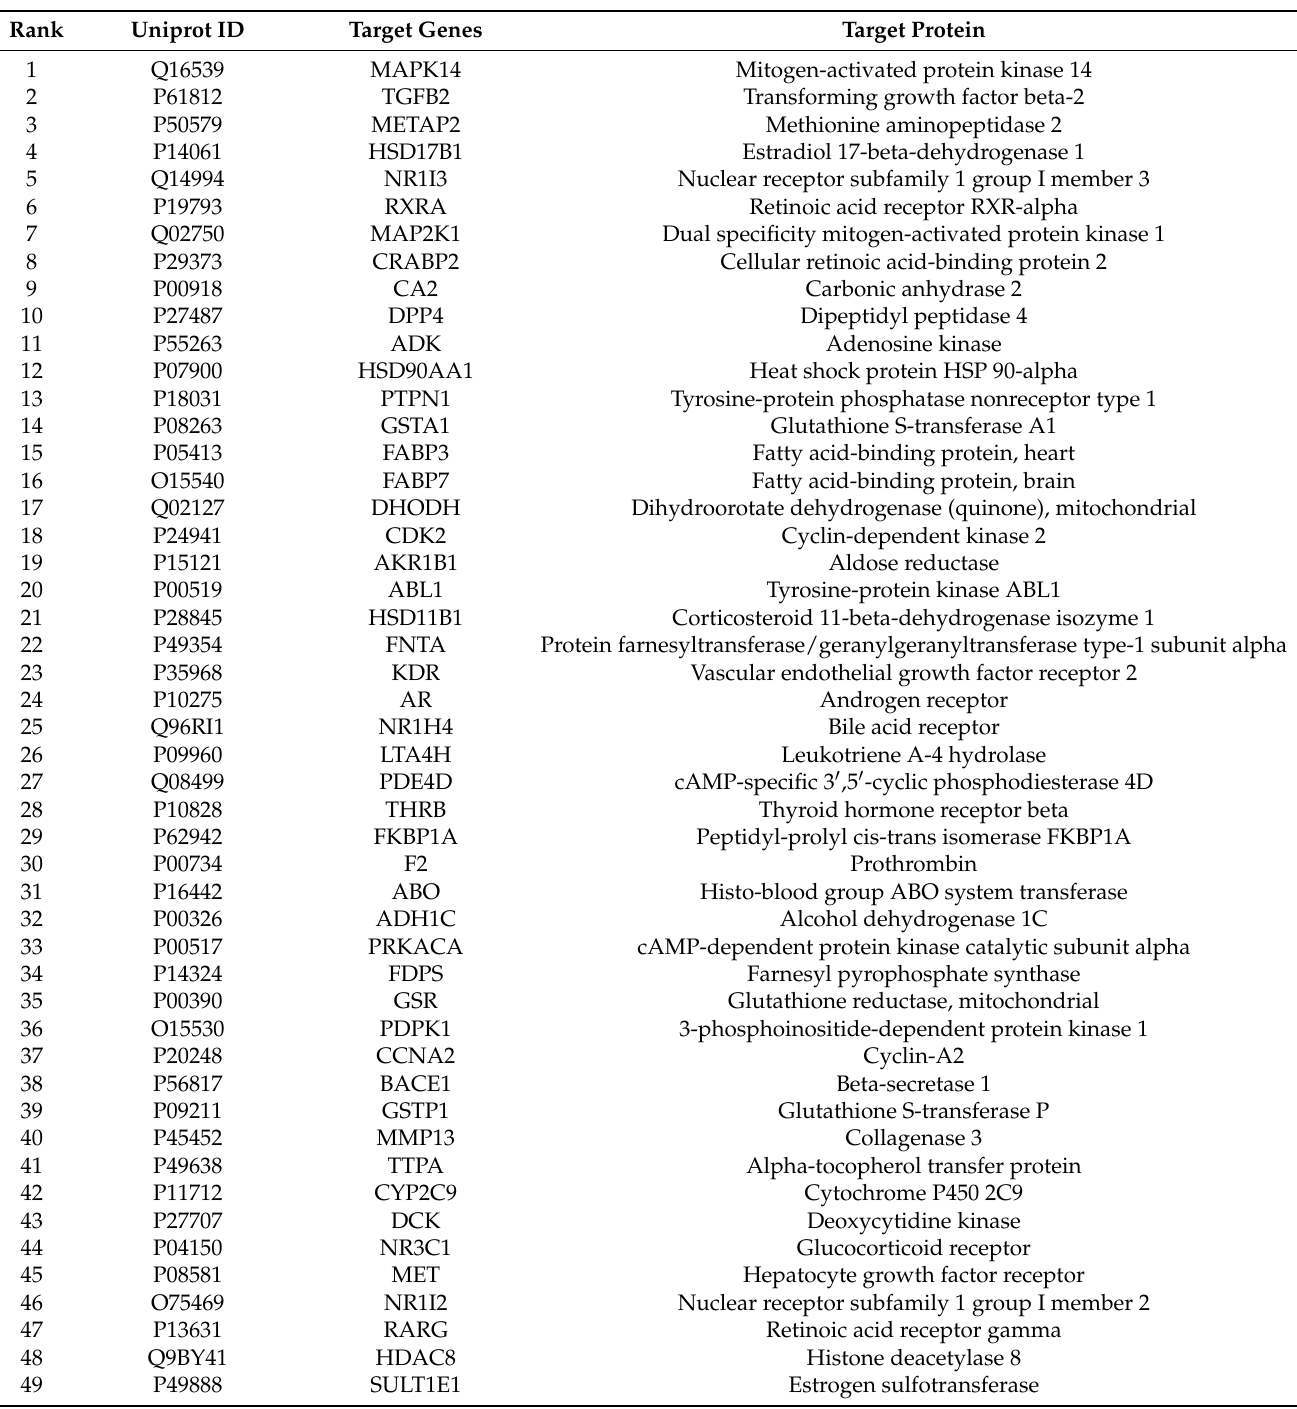
Table 3. All targets of 12 alkaloids in S. alopecuroides